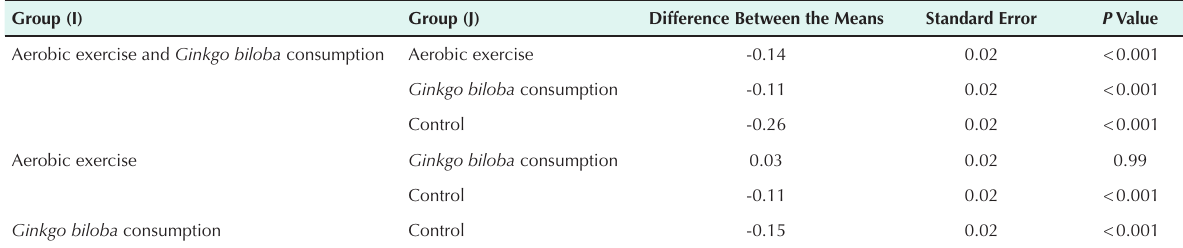
Table 6. Findings of Bonferroni Test Regarding Insulin